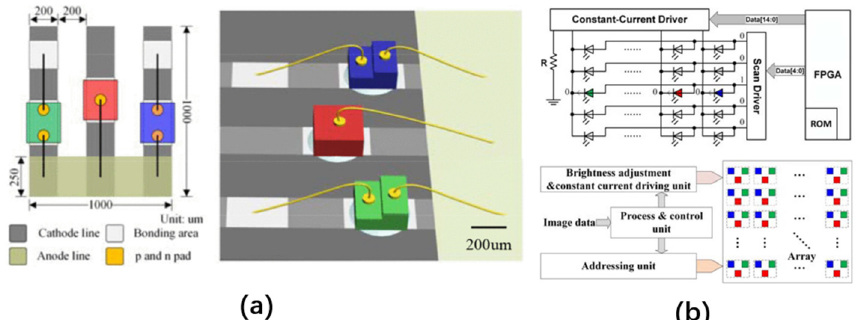
Figure 1. ( a ) Horizontally arranged red, green, and, blue (RGB) three-color light-emitting diodes (LED) pixel plane structure; ( b ) horizontally arranged RGB micro-LED array working principle. Reproduced from [29], with permission from Institute of Electrical and Electronics Engineers, 2016.